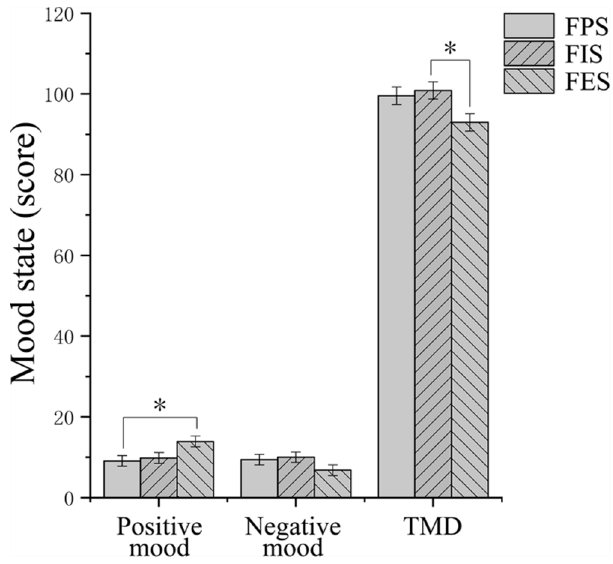
Figure 7. Mood state values among the three groups ( N = 20; mean ± standard error; * p < 0.05; ** p < 0.01).